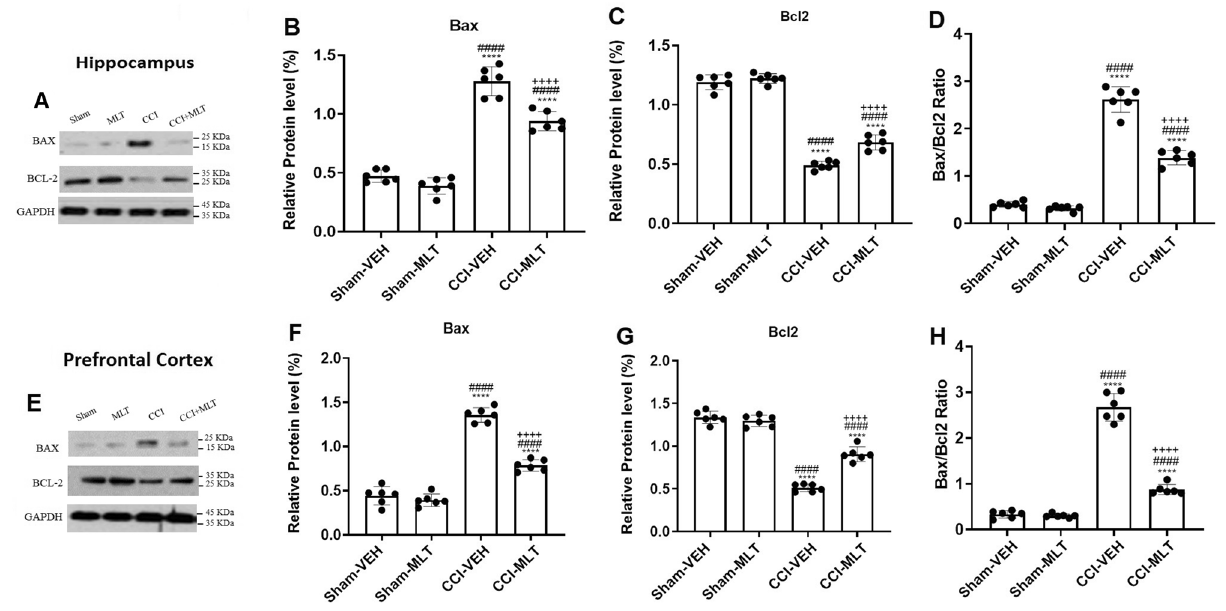
Figure 4. Effects of melatonin (MLT) on Bax and Bcl2 concentrations in the hippocampus (HC) and prefrontal cortex (PFC) of chronic constriction injury (CCI)-induced rats. ( A ) Results of western blot assay, concentrations of ( B ) Bax and ( C ) Bcl2, ( D ) Bax-to-Bcl2 ratio in the HC, ( E ) results of Western blot assay, concentrations of ( F ) Bax and ( G ) Bcl2, ( H ) Bax-to-Bcl2 ratio in the PFC. **** P < 0.0001 compared with the Sham-VEH group; #### P < 0.0001 compared with the Sham-MLT group, and ++++ P < 0.0001 compared with the CCI-VEH group. Sham-VEH: sham-operated animals, Sham-MLT: sham-operated animals MLT (10 mg/kg), CCI-VEH: pain- induced animals, and CCI-MLT: pain-induced animals received MLT (10 mg/kg), mean ± standard deviation, n = 6 per group. The original western blot images can be found in the figures S1 and S2 of the supplementary file. Images of blots with adequate length and membrane edges could not be provided because the blots were cut prior to hybridisation with antibodies and scanned at inside of blots,